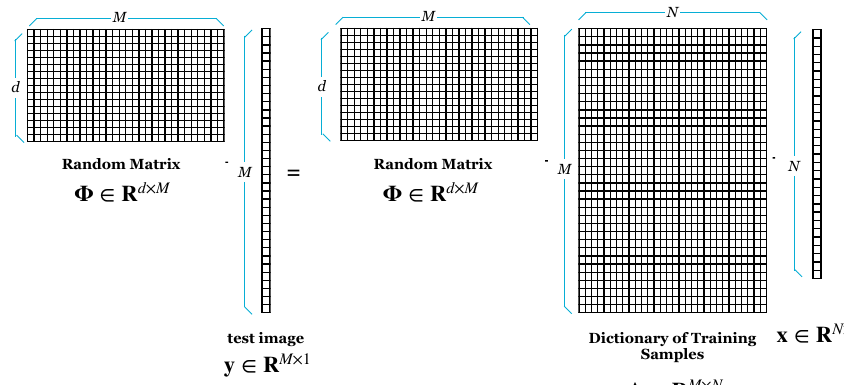
Figure 2. Dimensionality Reduction using Random